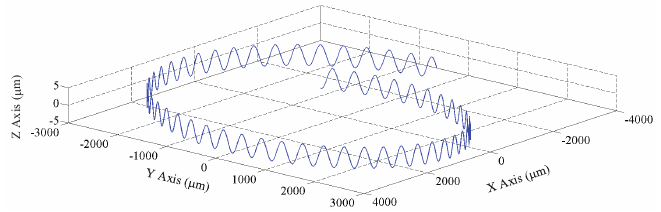
Figure 4. Trajectory of a diamond grit in